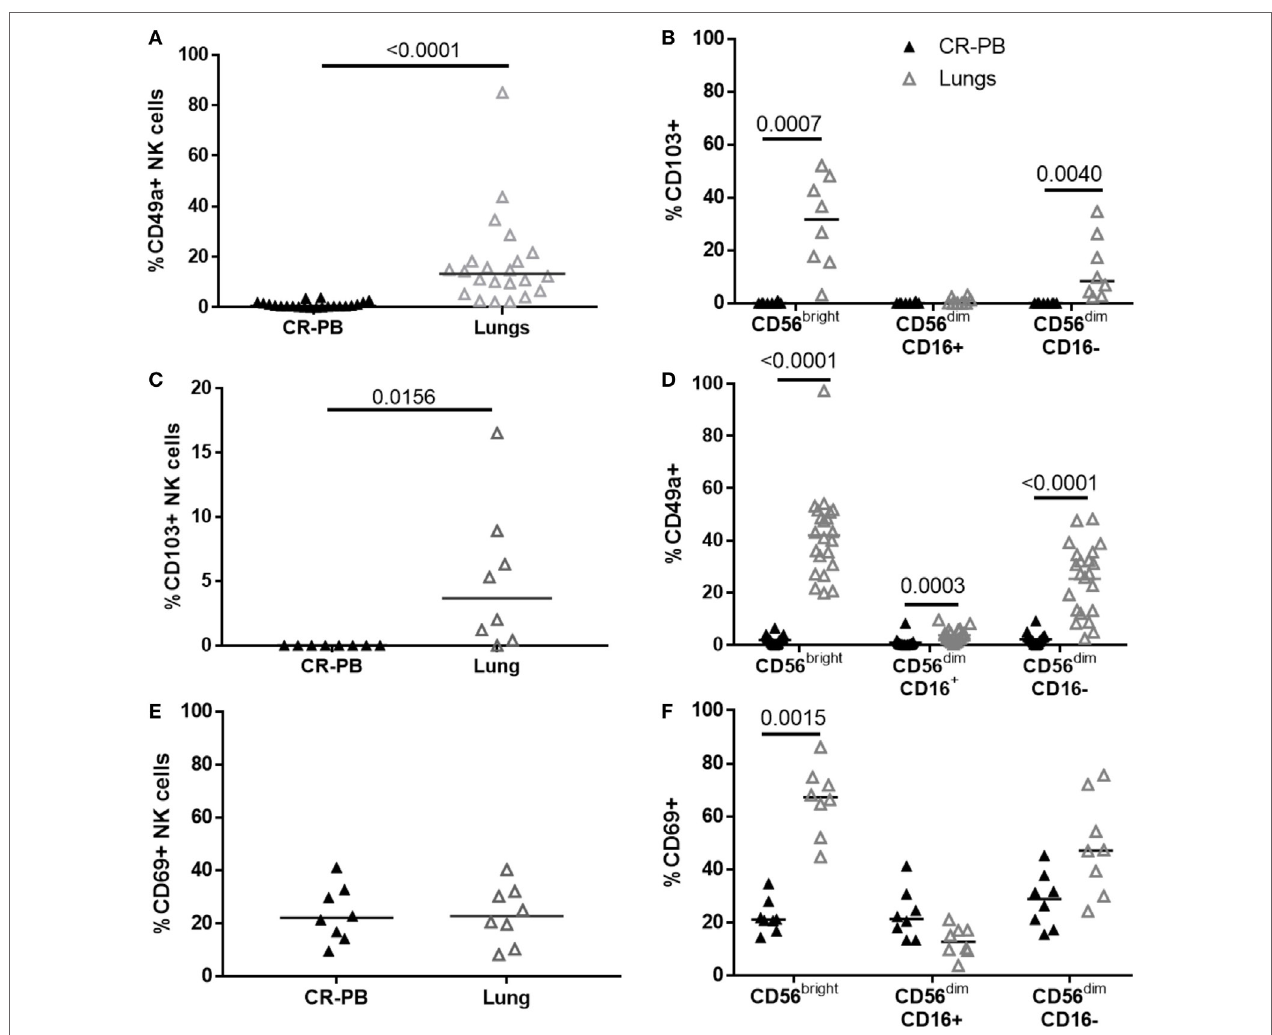
FigUre 4 | Distinct natural killer (NK) cell populations are present in the blood, but not the lung. (a,c,e) Flow cytometric analysis of CD49a ( N = 22), CD103 ( N = 8), and CD69 ( N = 8) expression on lung and blood NK cells. Statistical analysis performed by Wilcoxon signed-rank test. Lines describe medians. (B,D,F) Residency marker expression on CD56 bright and CD56 dim NK cell subsets. Statistical analysis by Friedman’s test with Dunn’s multiple comparison